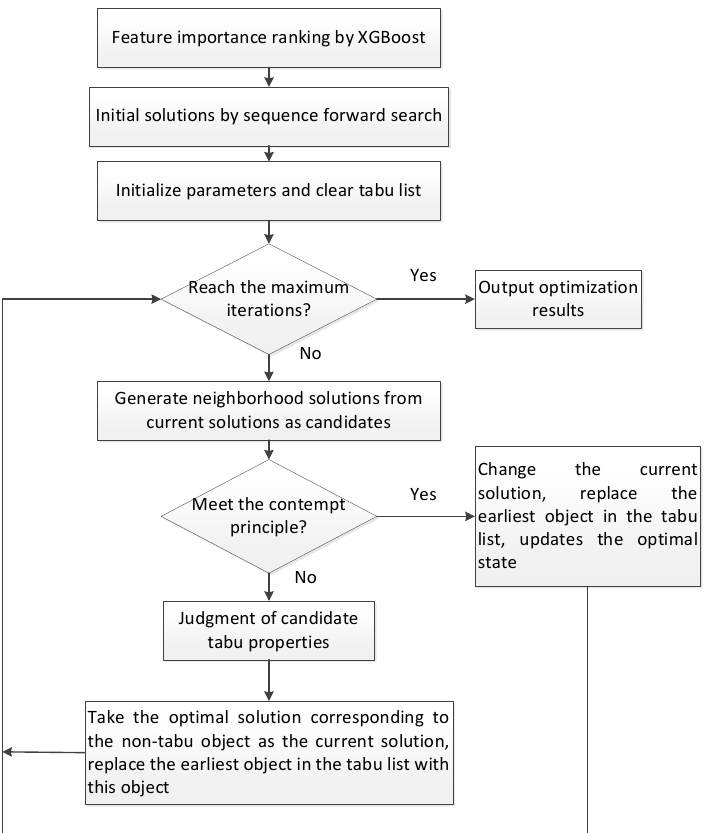
Figure 1. Basic steps of the gain sequence forward tabu search (GSFTS) algorithm.